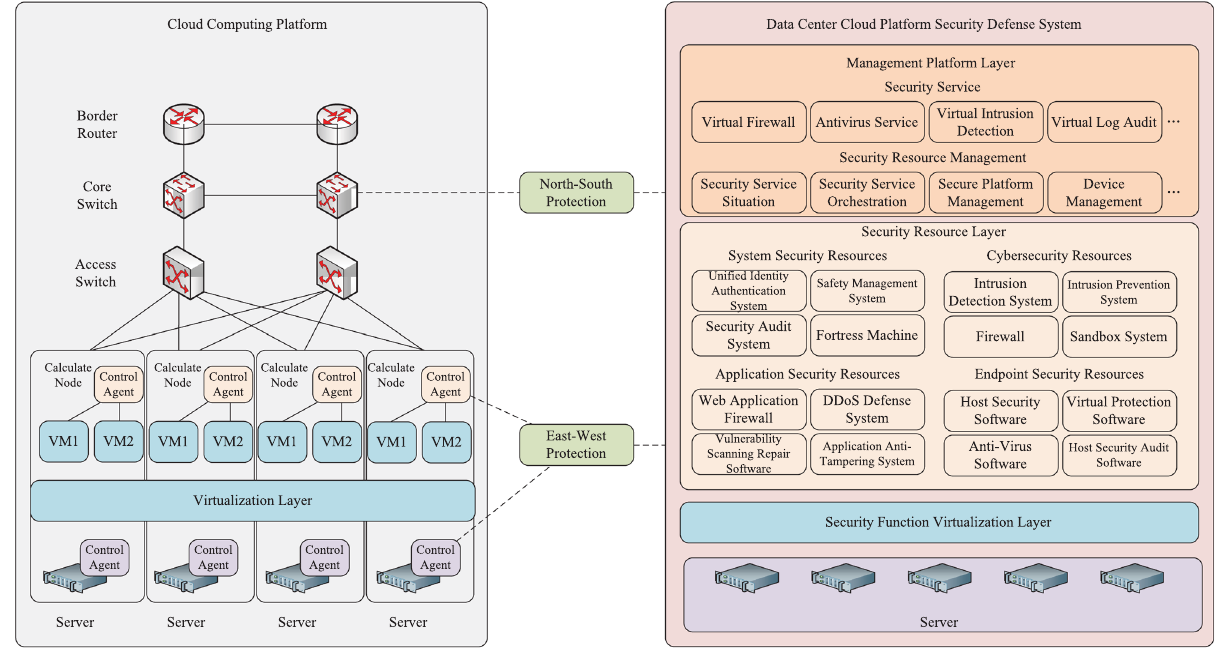
Figure 4: Space TT&C cloud platform security protection architecture